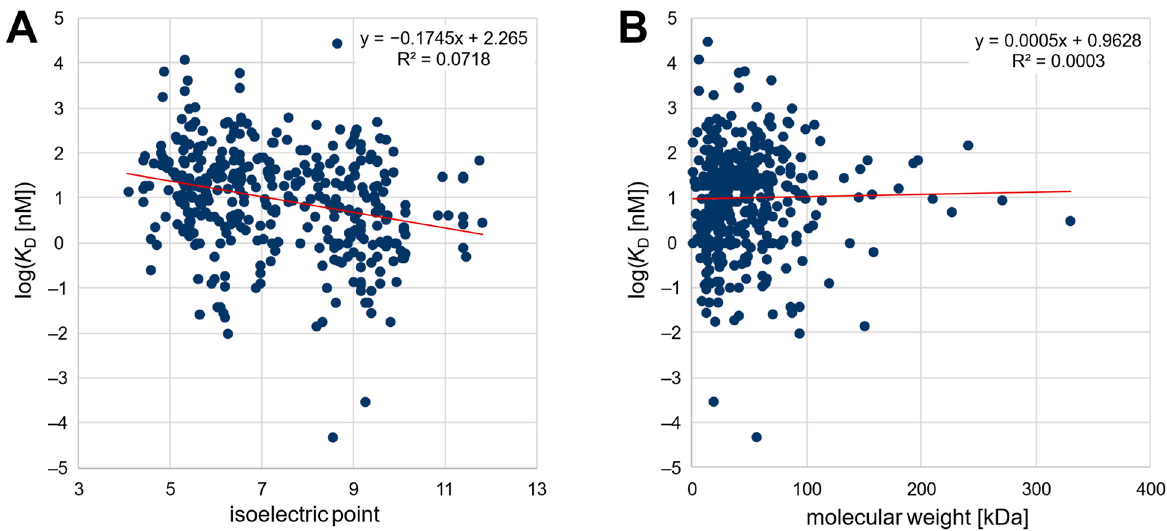
Figure 1. ( A ) Plot of the affinity of 369 aptamers against the isoelectric point and ( B ) against the molecular weight of the target peptide/protein.